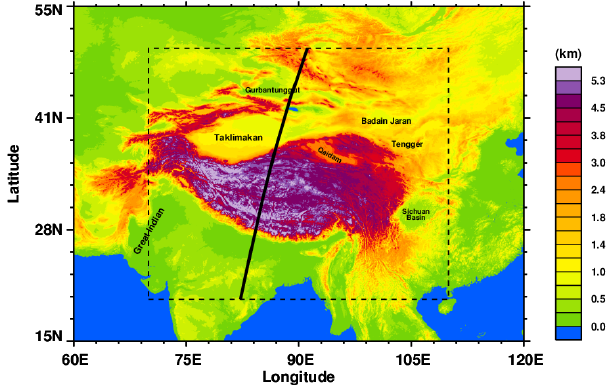
Figure 1. Modeling domains and topography over the vicinity of the TP; the contours of the terrain height are in km (above mean sea level). The solid black line indicates the trajectory of the CALIPSO satellite over the TP on 22 August 2007. The black rectangle indi- cates the survey